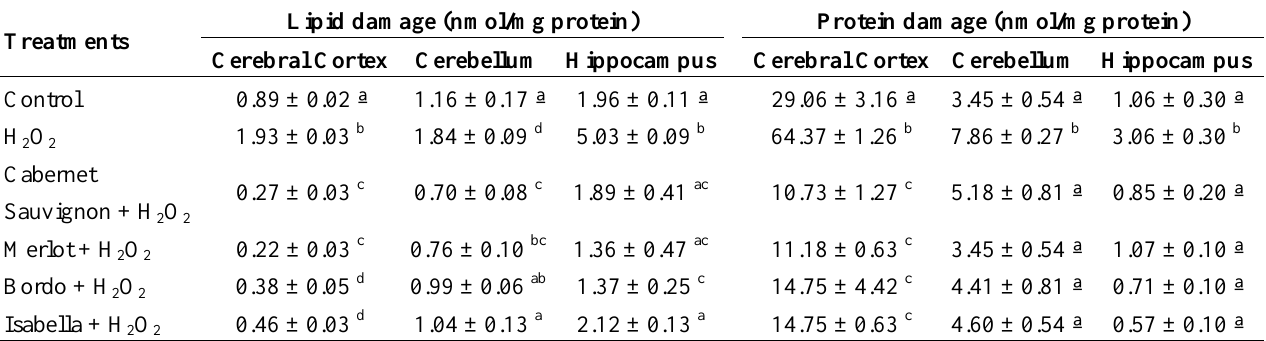
Table 2. Lipid and protein damage in the cerebral cortex, hippocampus and cerebellum of rats treated with the wine waste extracts plus hydrogen peroxide.